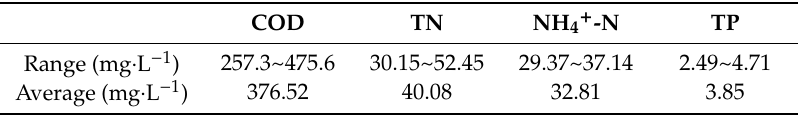
Table 1. Characteristics of synthetic